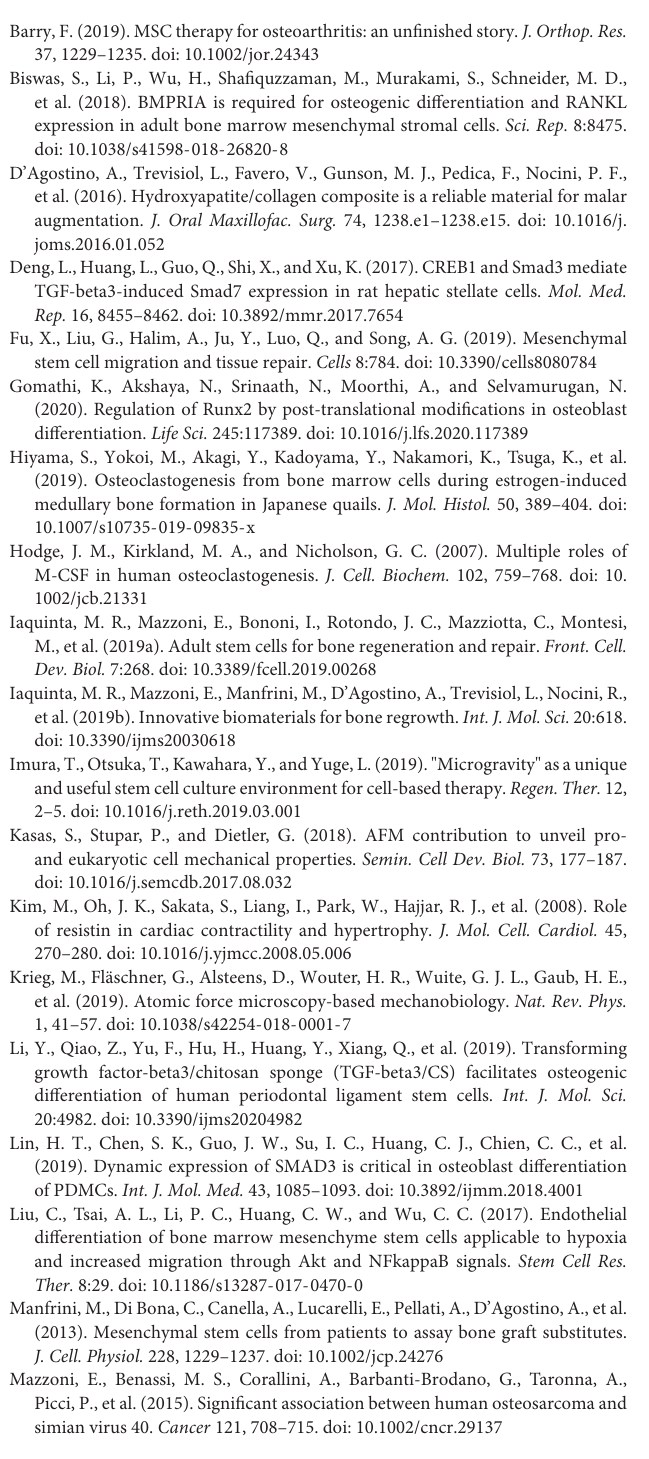
Supplementary Figure 1 | Stem cell viability and cytoskeleton architecture assays carried out in hBMC monolayers grown in 24 well tissue culture polystyrene (TCPS). Representative images of hBMC cultures obtained by fluorescent microscope analysis. (A) hBMCs expressing green fluorescence;